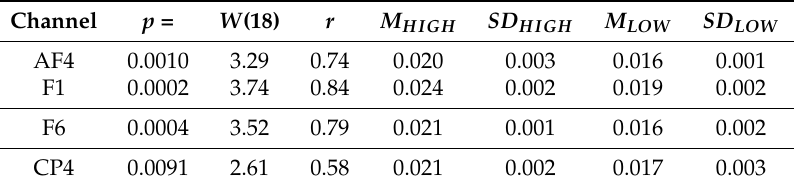
Table 1. Eyes-Closed (EC) setting. Channel-wise paired Wilcoxon rank sum test for four channels (AF4, F1, F6, and CP4) in which significantly higher total TEs were associated with HIGH stress-susceptible group. p , W , and r refer to p -value, test-statistics, and the effect size for Wilcoxon rank sum tests. M and SD are the mean and standard deviation of these channels’ total TE values. The subscripts to M and SD mark the two groups. All these significant differences were characterized by strong effect sizes, as indicated by the “ r ” column entry of this table.